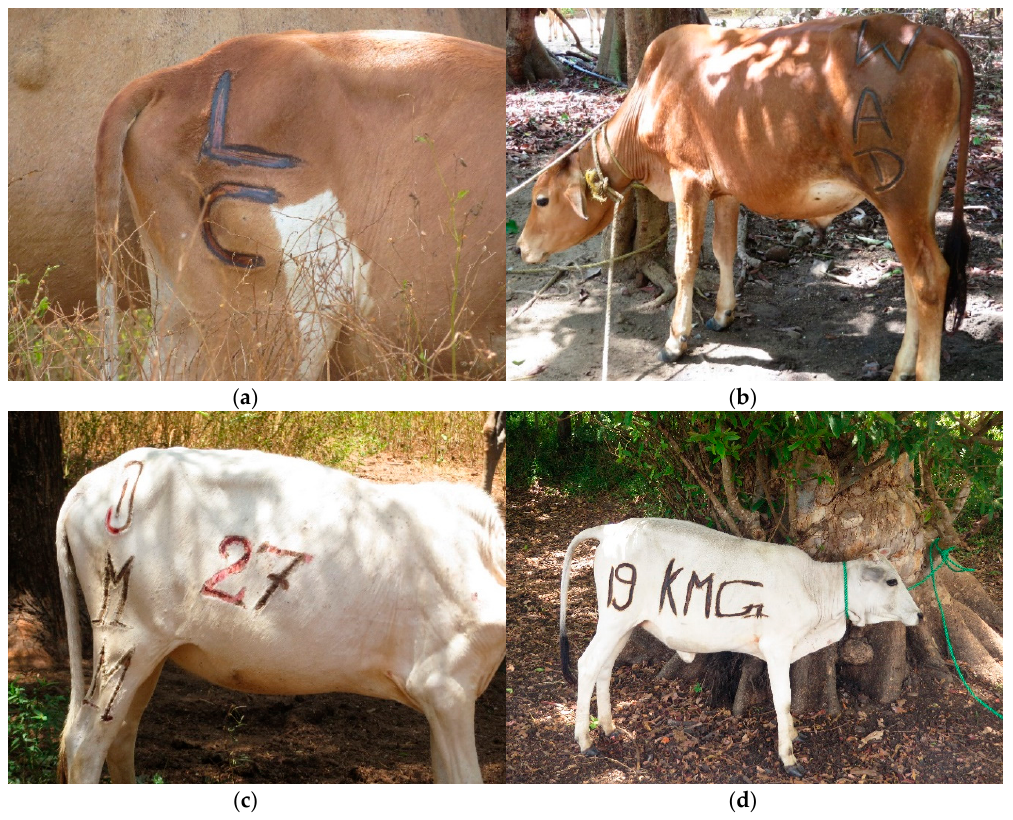
Figure 3. Brand size and location on Farm 1 ( a ), Farm 2 ( b ), Farm 3 ( c ), and Farm 4 ( d ). For Farm 3, the calf fled immediately after branding and we were unable to photograph her, so ( c ) shows an animal branded one week earlier from the same farm.